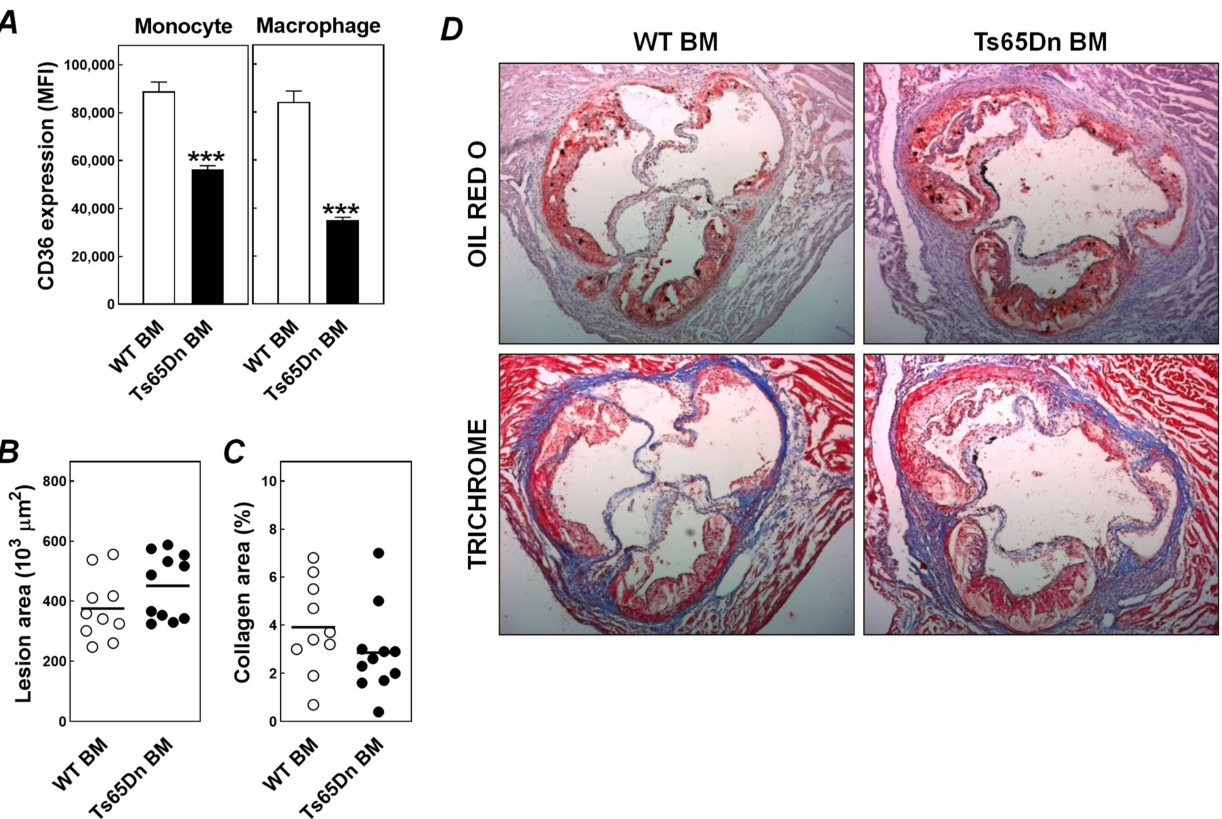
Figure 2. Bone marrow trisomy is not associated with an altered atherosclerosis susceptibility despite a reduced mono- cyte/macrophage CD36 expression. ( A ) Relative protein expression levels of CD36 in blood monocytes and splenic macrophages, ( B ) aortic root atherosclerotic lesion sizes and ( C ) lesional collagen contents in Western-type diet-fed LDL receptor knockout mice that have received wild-type bone marrow (WT BM) or Ts65Dn bone marrow (Ts65Dn BM). Data in panel A represent means + SEM of 6 mice per group. Horizontal lines in panels B and C indicate respective group averages of the depicted individual mice. *** p < 0.001 versus WT BM. Panel D shows representative images of atherosclerotic lesions stained for neutral lipids (Oil red O) or collagen (Trichrome; blue